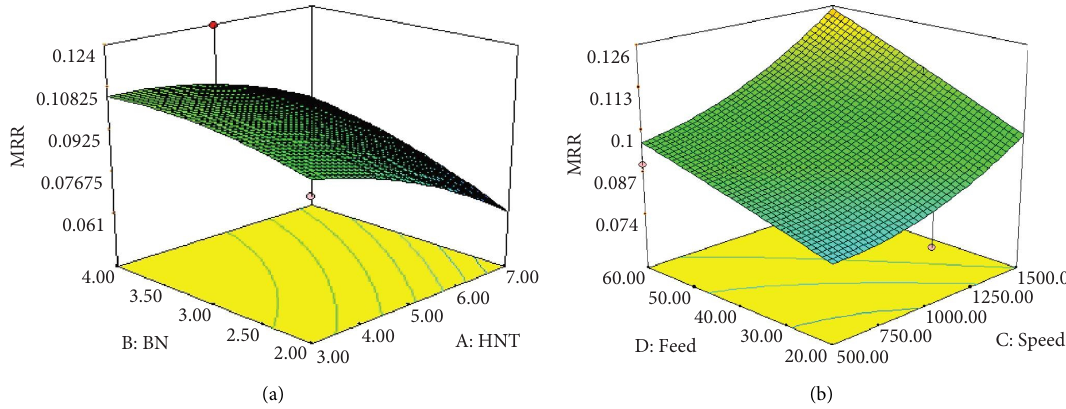
Figure 3: (a) Efect of MRR on HNT vs. BN. (b) Efect of MRR on HNT vs. BN.